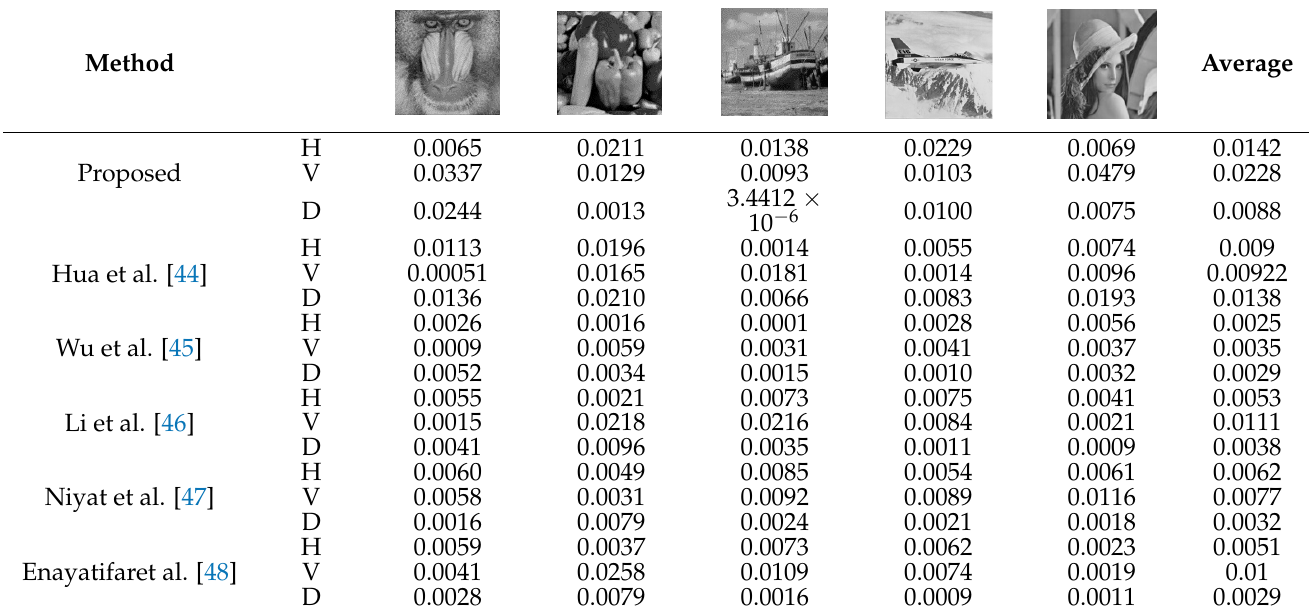
Table 5. Correlation coefficients in three directions: Horizontal (H), Vertical (V), and Diagonal (D) for images with size 256 × 256.